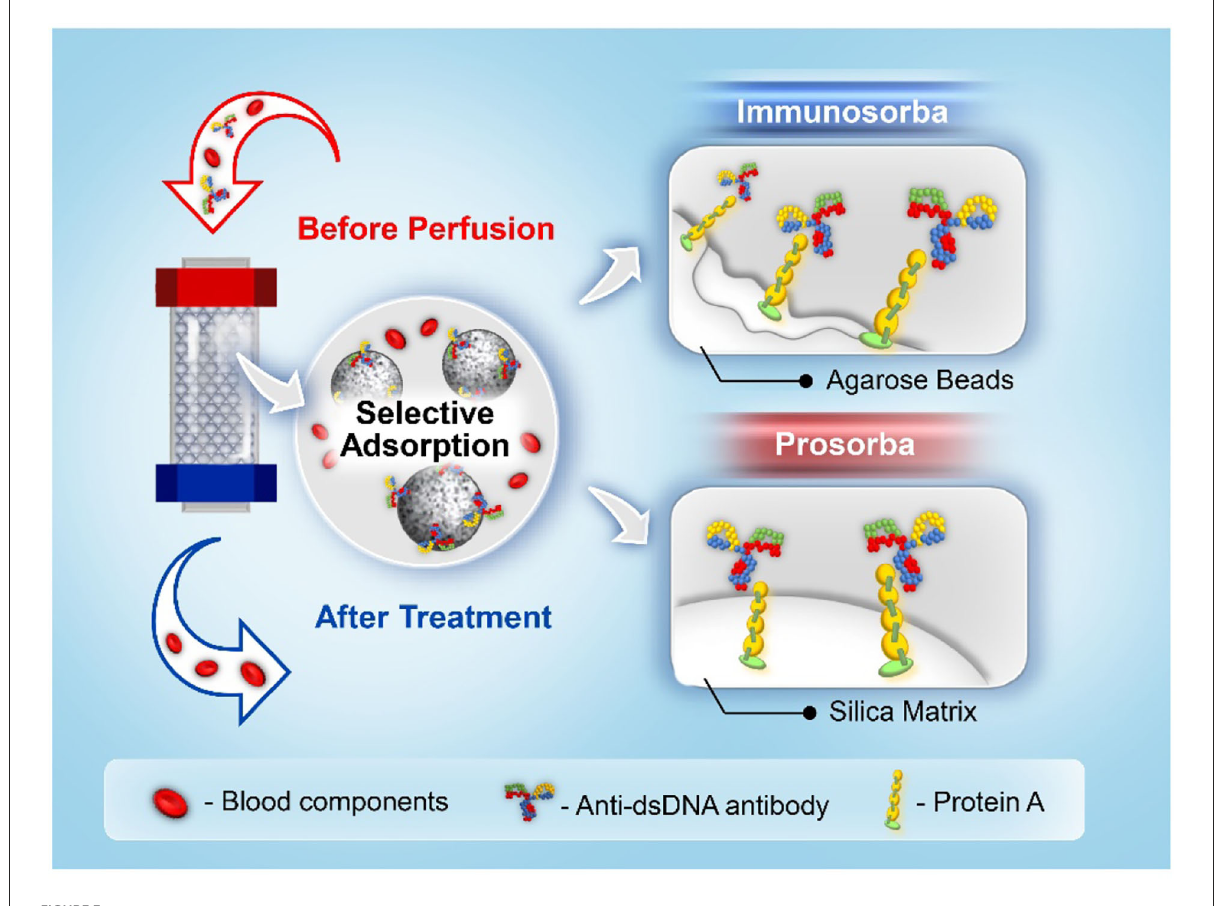
FIGURE3 A schematic illustration of protein A Immunosorba and